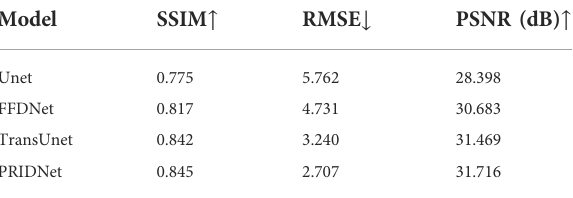
TABLE 1 The performance comparison results of the various deep learning-based denoised images related to subcellular detection with three different metrics (SSIM, RMSE, and